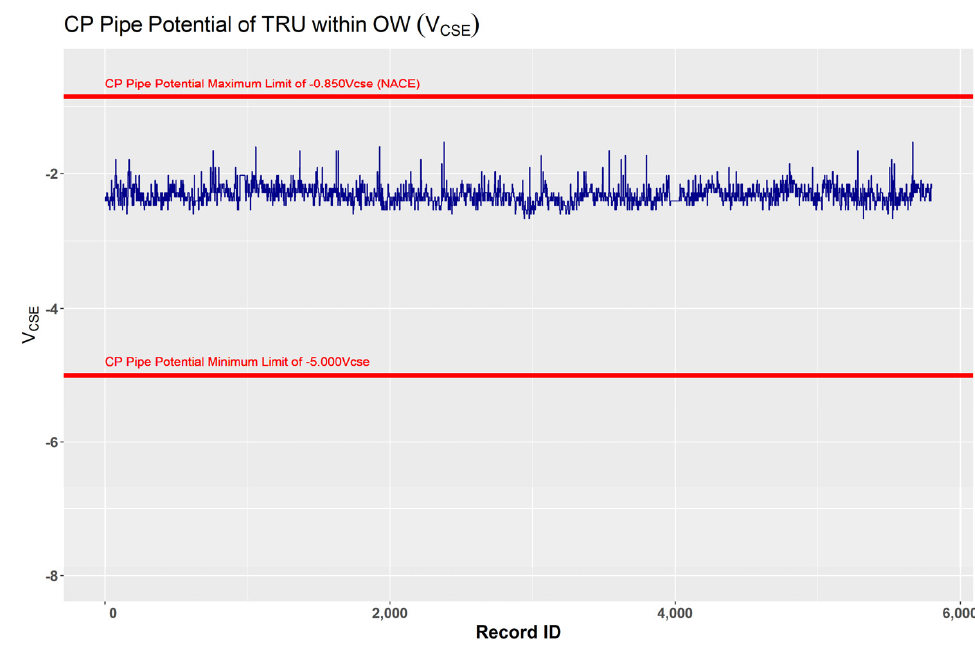
Figure 5. CP pipe potential within operating window.